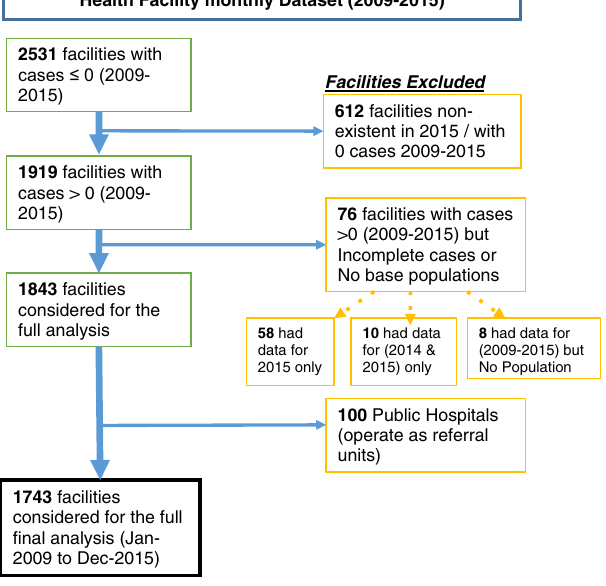
Fig. 1 Summary schema of fi nal health facility-level analysis. A work fl ow of the process of cleaning the dataset and the exclusion/inclusion criteria applied to arrive at the fi nal dataset